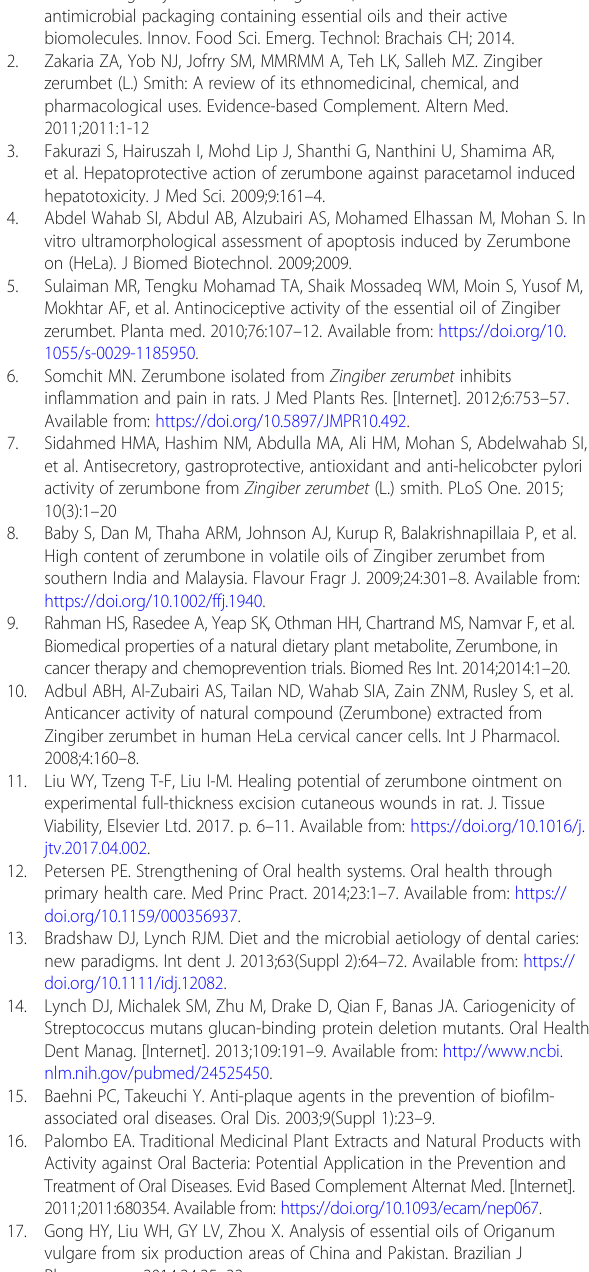
Additional file 1: Figure S1. Agar BHI showing presence or absence of S. mutans CFU representing the MIC and MIB of zerumbone against S. mutans. Results are representative of three independent experiments performed in triplicate. Arrows: CFU. (PPTX 454 kb) Additional file 2: Figure S2. Bacterial growth curve of S. mutans cells grown in BHI broth for 48 h at 37 in atmosphere of 5% CO 2 at 37 °C. (PPTX 43